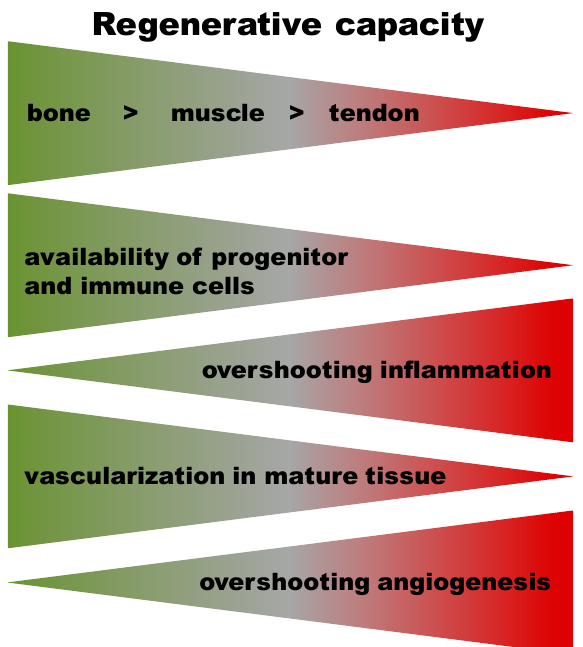
Figure 3. The regenerative capacity differs among musculoskeletal tissues with a high regenerative capacity in bone and a poor one in tendon tissue. The resultant “gradient” of capacity across tissues appears linked to the availability of progenitor cells within the tissues. Stem and progenitor cells reside in the bone marrow and adjacent periosteum/endosteum. They are easily recruited to a bone injury and ready to proliferate and differentiate. They represent a source of important signaling molecules for successful healing (e.g., BMP2). Muscle regeneration after injury relies on interspersed satellite cells and newly detected local stem cells. The available quantities of tissue-residing pluripotent cells appear to be lowest in tendon. The appearance of pluripotent cells post-injury depends on the capacity to form new vessels. After bone injury, revascularization is intense, starting from the periosteum/endosteum and surrounding muscle tissues. To a similar degree, vessel density reappears after muscle injury. The lowest vessel density occurs in tendon, and thus, re-vascularization following injury is a challenge. Surprisingly little is known about the time course of inflammation across these tissues following injury. A pro-inflammatory phase appears to be present across all mesenchymal tissues. In bone, pro-inflammation is followed by distinct anti-inflammation, which seems to be missing or delayed in muscle tissues.